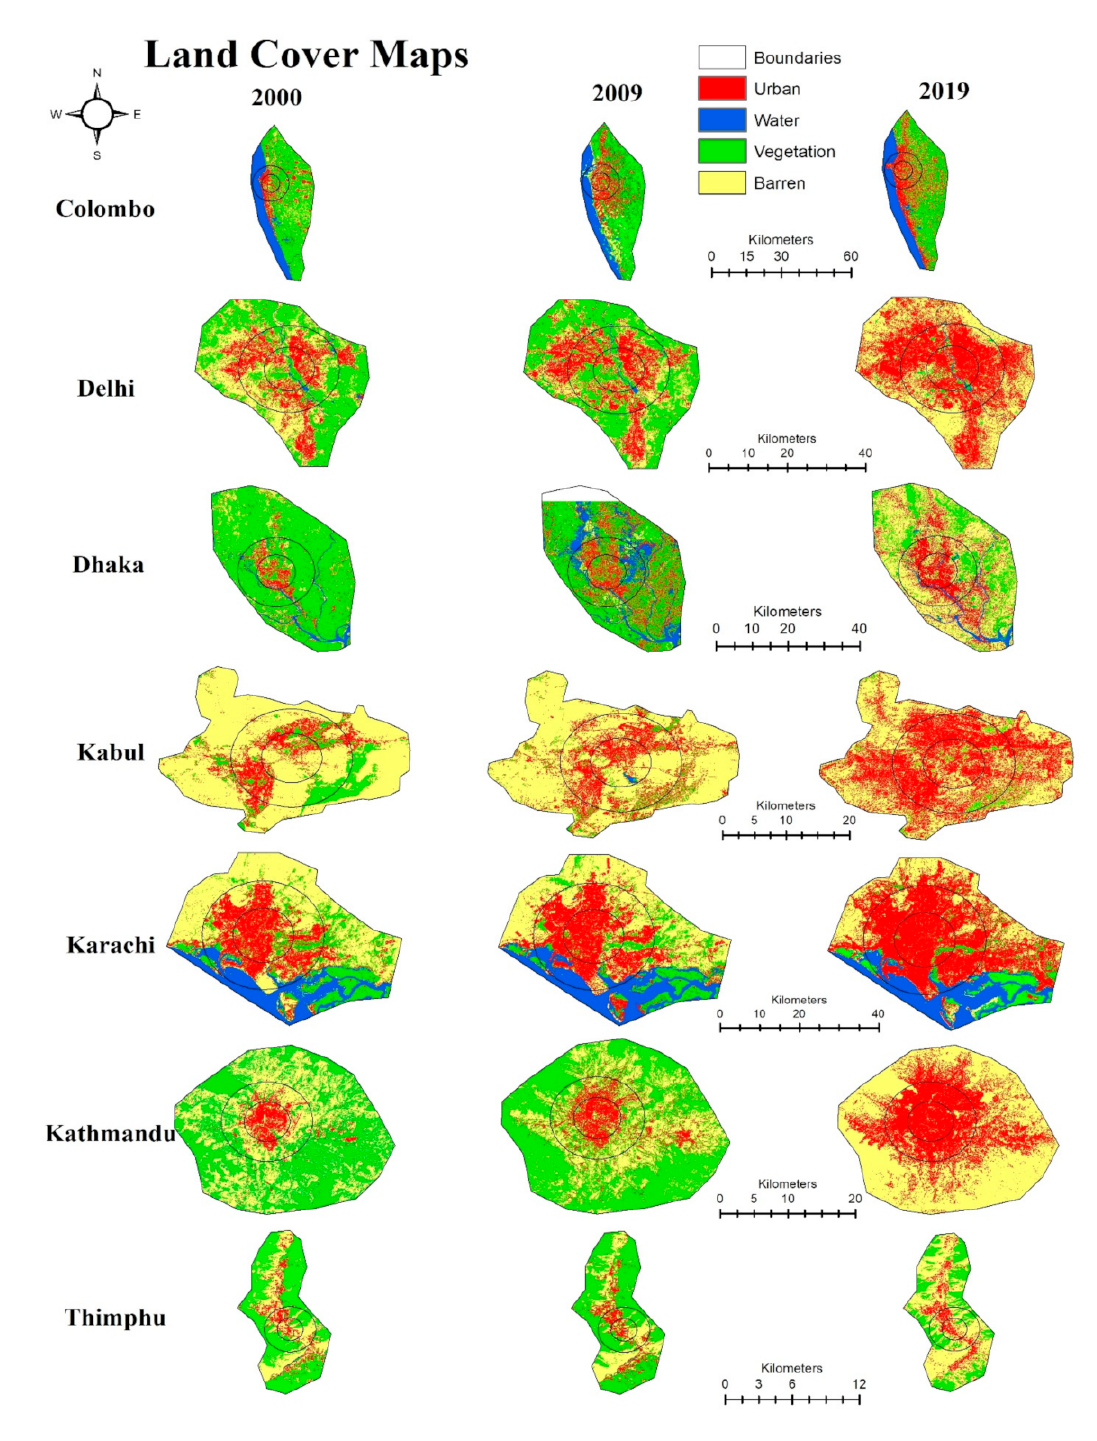
Figure 4. Land Cover Maps of SA Cities 2000, 2009 and